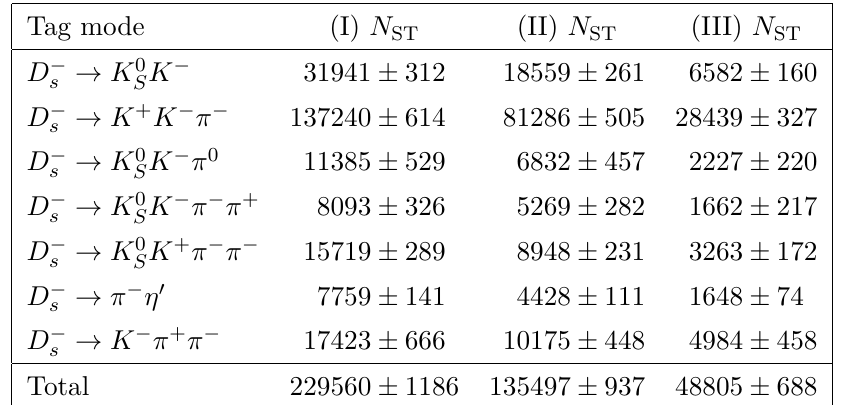
√ s = (I) 4.178 GeV, (II) 4.189-4.219 GeV, and